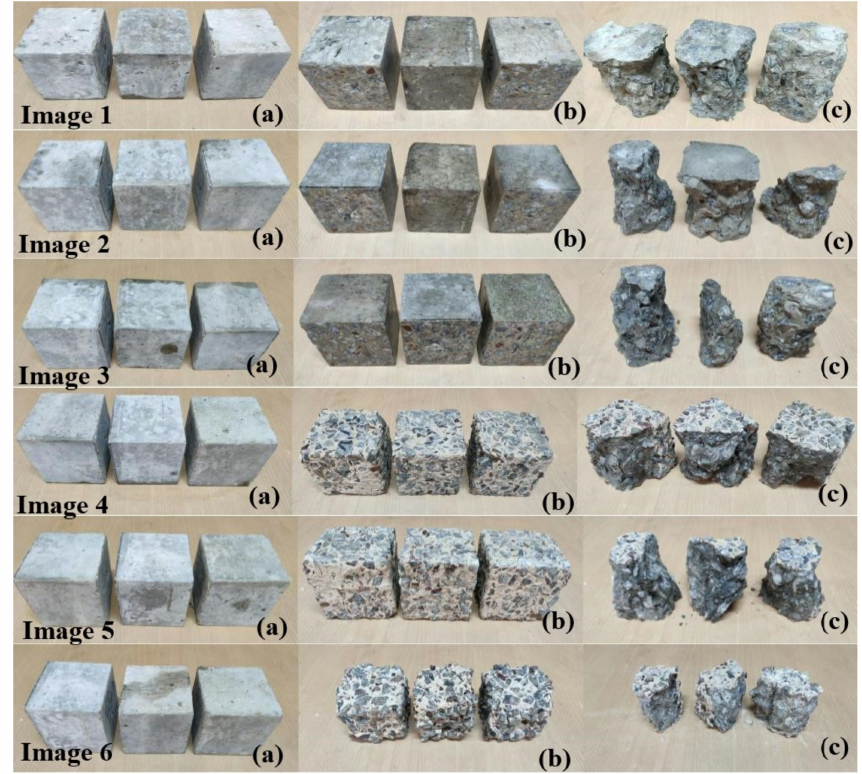
Figure 6. Effect of acid and sulphate attack on bacterial concrete with different intervals